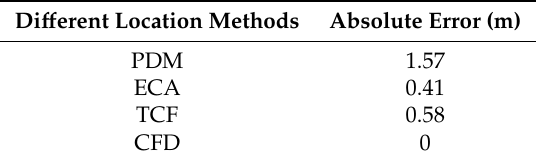
Table 2. Comparison of location results.